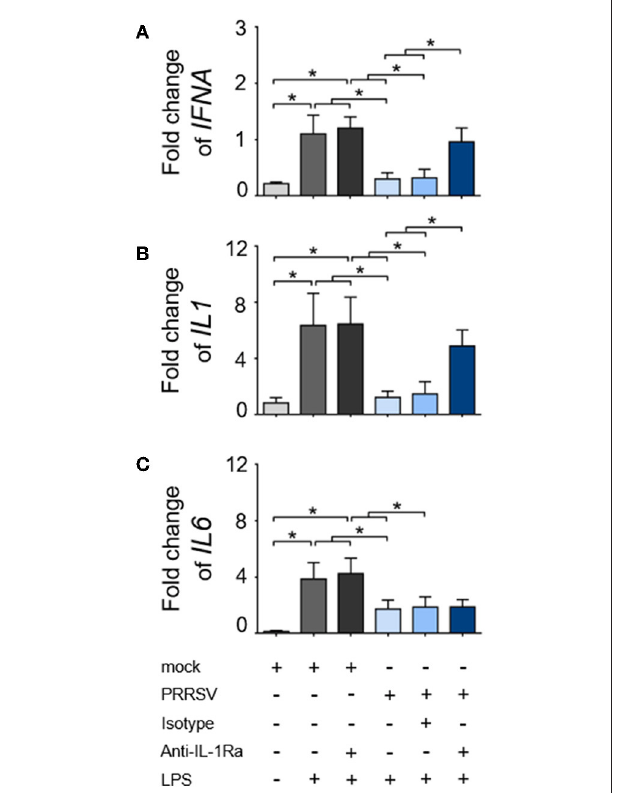
FIGURE 2 | PRRSV-induced IL-1Ra inhibited (A) IFNA and (B) IL1 , (C) but not IL6 expression. MoDC were cultured with type 2 PRRSV or mock, in the presence of anti-IL-1Ra Ab. LPS was added into the culture and further incubated for 24h. ± indicates presence/absence of indicated treatment within the culture. Data represents mean ± SD from 5 pigs. Statistical significance was analyzed using ANOVA followed by Tukey’s test. * indicates significant difference at p <